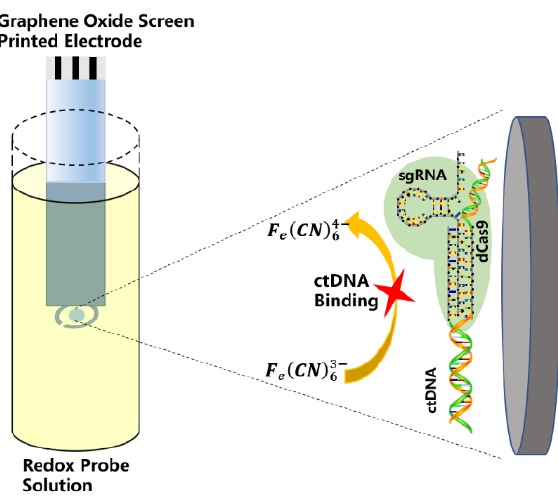
Figure 9. Schematic of a biosensor modified by dCas9–sgRNA (Adapted with permission from Ref. [48]. 2020, Uygun et al.).